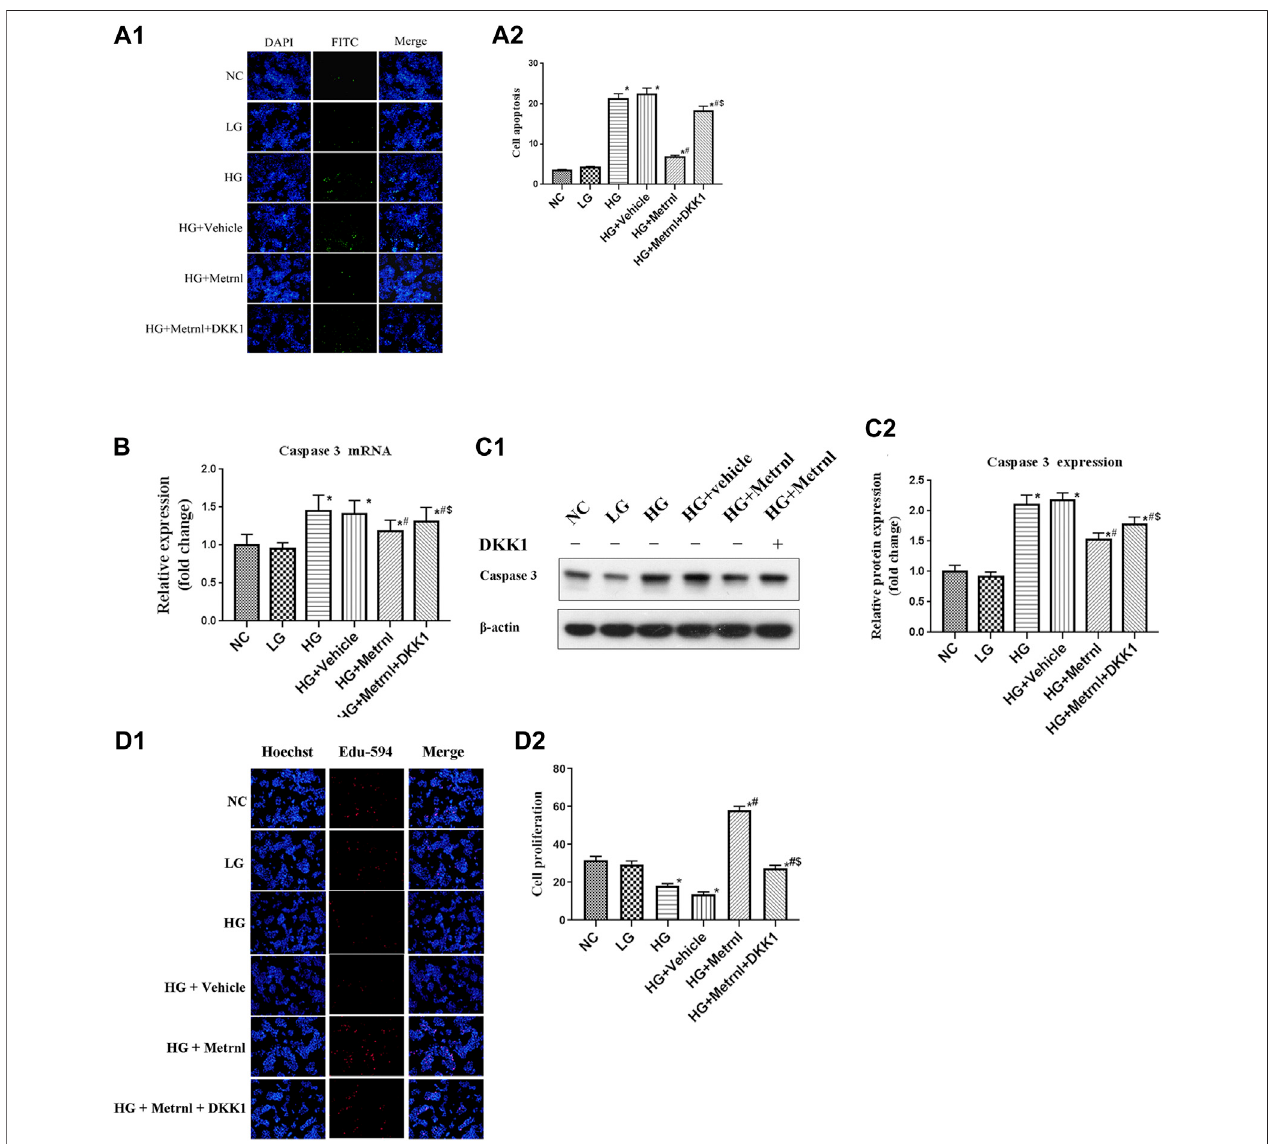
FIGURE 4 | (A) β cell apoptosis between different groups assessed by TUNEL assay. NC: normal control, LG: low glucose, HG: high glucose, DKK1: dickkopf 1. (B) The gene expression of caspase 3 was quanti fi ed by real-time PCR. Data are presented as the fold change of transcripts for the target gene in the indicated groups normalized to β -actin. All data are expressed as mean ± SEM [ n (cid:2) 8/group (mRNA)]. (C) Representative western blot showing caspase 3 protein levels in MIN6 cells of differentgroups.Banddensitieswereconvertedtoabargraph.Alldataareexpressedasmean ± SEM[ n (cid:2) 8/group(protein)]. (D) β cellproliferationevaluatedusing Edu-594 staining between differentgroups. * p < 0.05 for differences vs. normal control group; # p < 0.05 for differences vs. HG group; $ p < 0.05 for differences vs. HG + Metrnl group. NC: normal control, LG: low glucose, HG: high glucose, DKK1: dickkopf